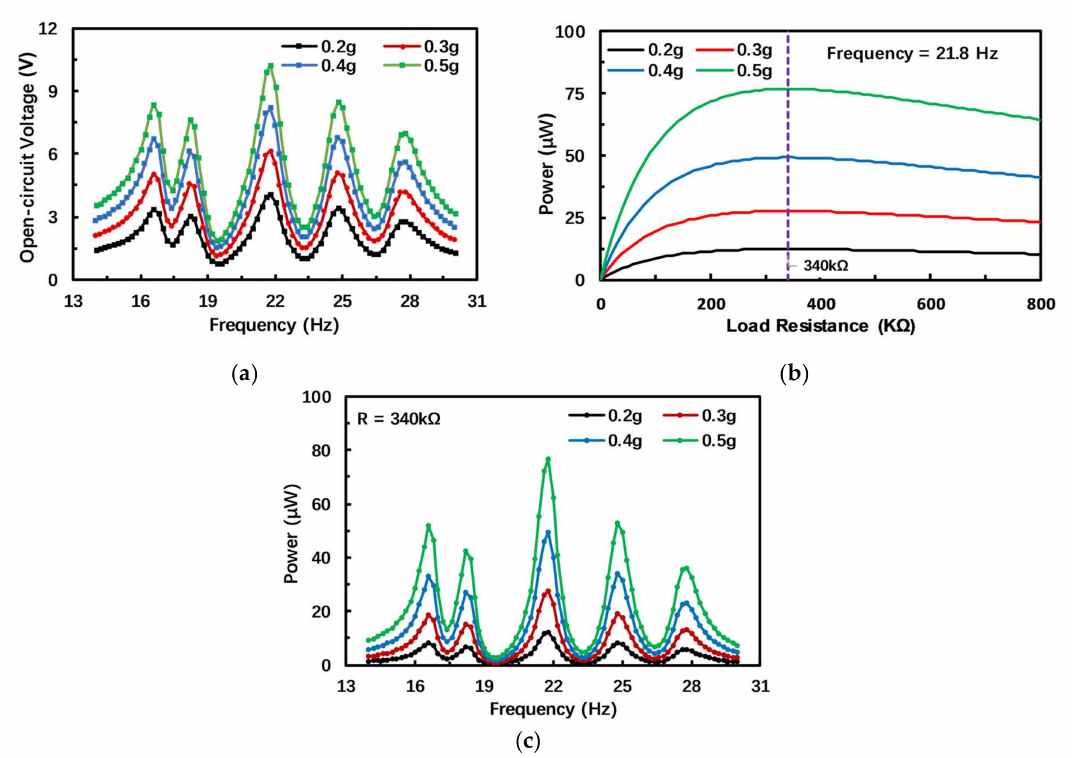
Figure 4. Simulation results of the output characteristics of the PEH. ( a ) Simulation results of frequency response of open-circuit voltage; ( b ) Simulation results of output power against load resistance under different acceleration amplitudes; ( c ) Simulation results of frequency response of output